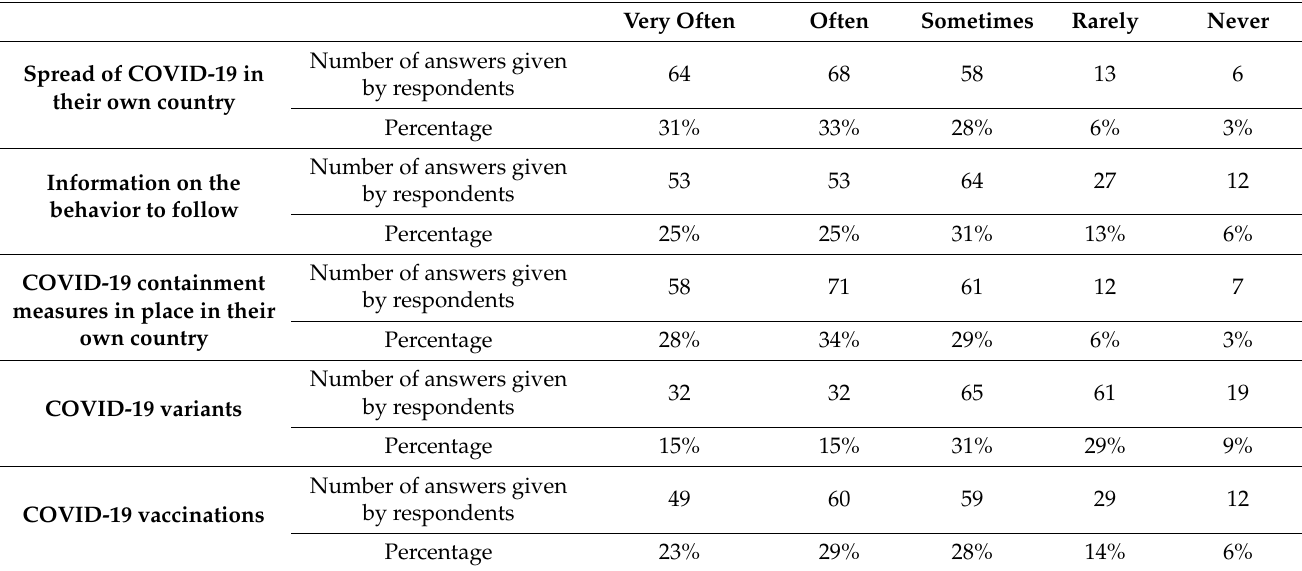
Table 13. Kind of information searched online regarding